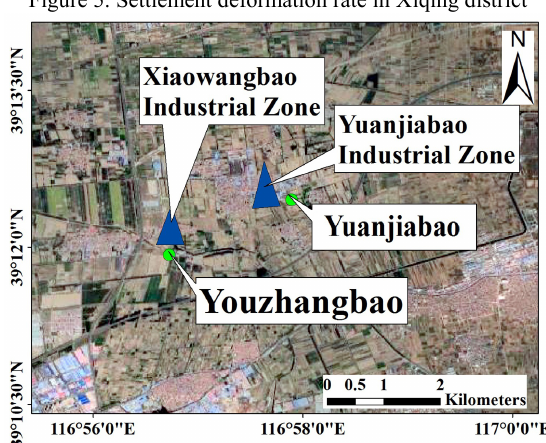
Figure 4. Leveling results and SBAS-InSAR processing results